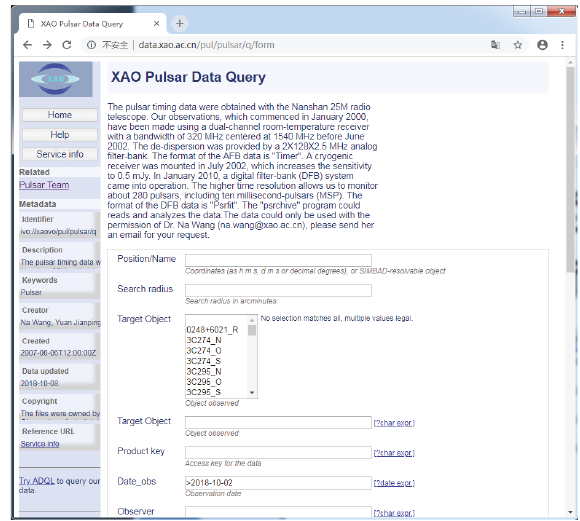
Figure 3: XAO pulsar data retrieval interface.